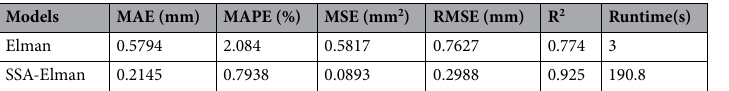
Table 5. Evaluation index value and average running time of Elman, SSA-Elman.